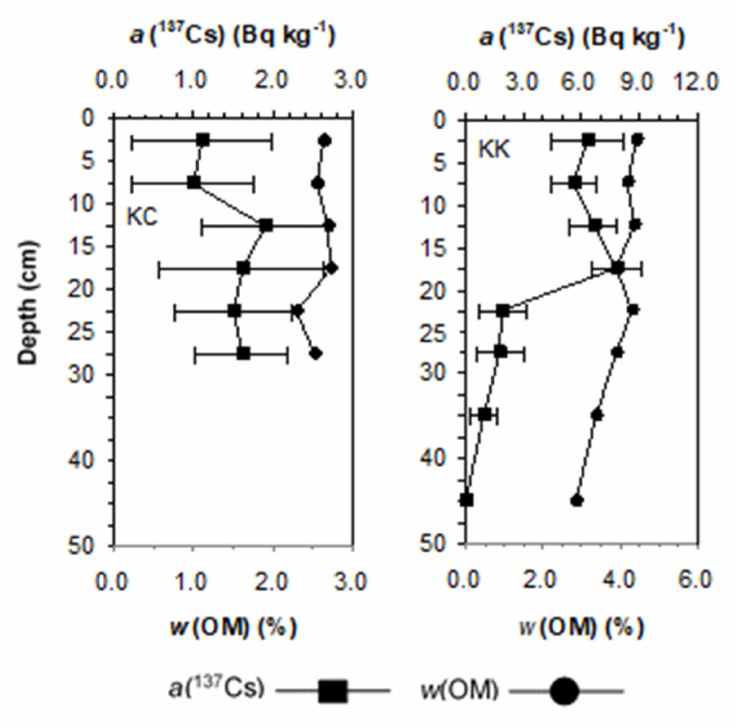
Figure 8. 137 Cs massic activity profiles reflecting anomalies in sedimentation processes and organic matter mass fraction profiles. Measurement uncertainties are expressed with k = 2 for normal distribution.